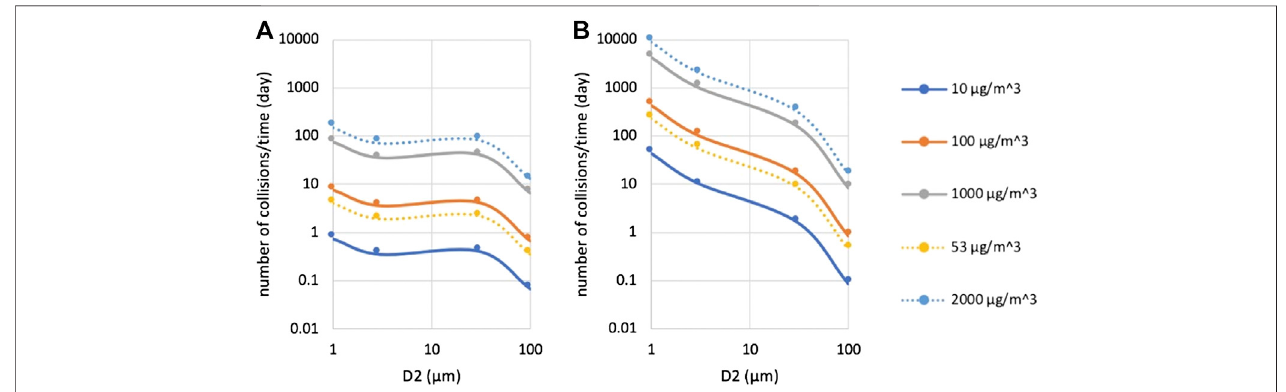
FIGURE 6 | Collision rate with respect to one speci fi c particle whose diameter is D1 (cid:1) 10 mm, interacting with another particle whose diameter is represented by D2.Differentlinescorrespondtodifferentconcentrationvalues.Whilesolidlinesshowthreedifferentordersofmagnitudes(10 μ g/m 3 ,100 μ g/m 3 ,1,000 μ g/m 3 );dashed linesarerelativetothevaluesmeasuredbyWeberetal.(2012)inMay2010atEyjafjallajökull(Iceland)(seetextfordetails). (A) isrelativetoneutralparticles; (B) isrelativeto oppositely charged particles at the ionization limit.